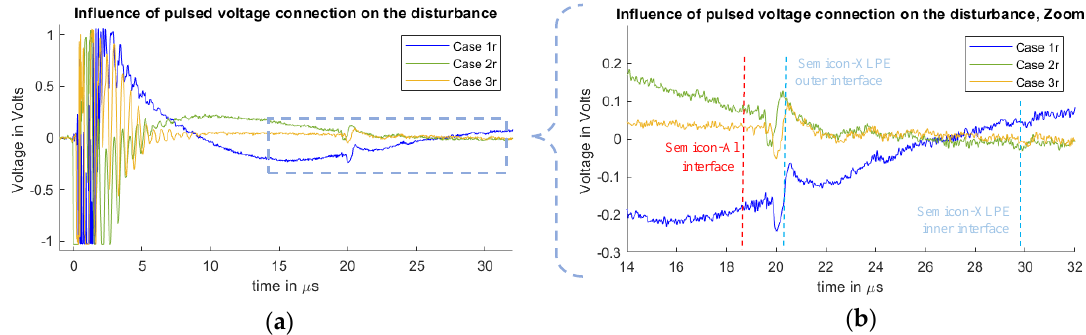
Figure 8. Measured disturbance from Cases 1r, 2r and 3r. ( a ) Full measured signal ranging from the instant of the pulsed voltage application up to 32 µs. ( b ) Zoom to the time instant of the acoustic signal arrival belonging to the charge measurements.